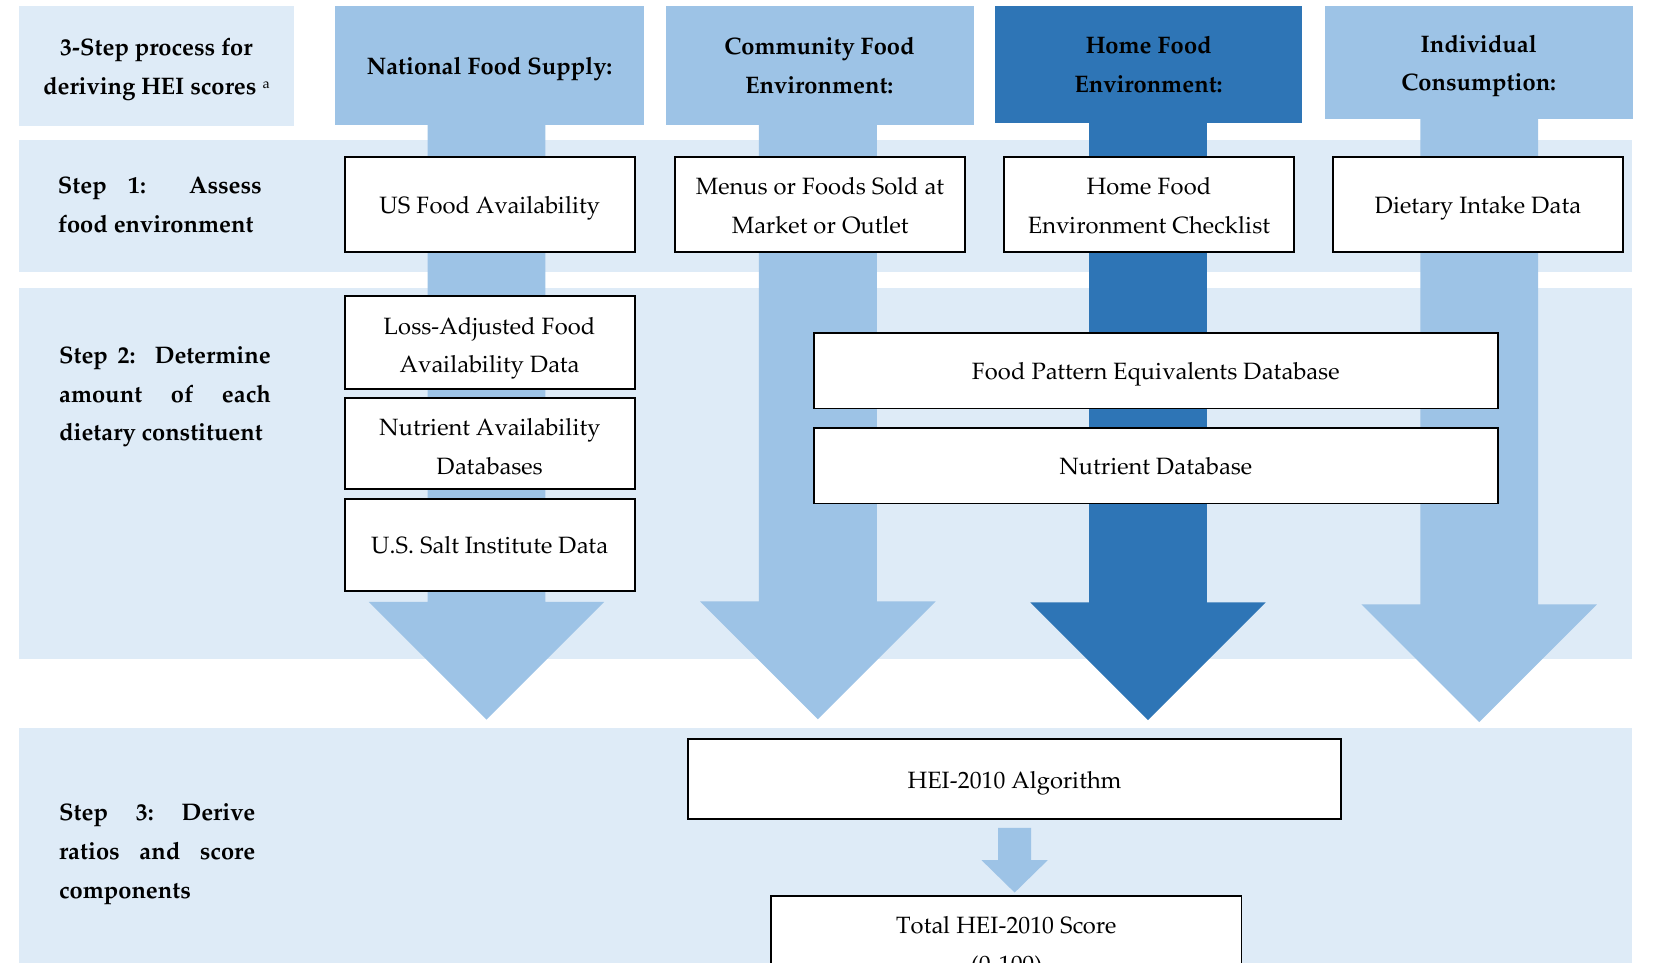
Figure 1. Three step process for deriving Healthy Eating Index (HEI) scores across different levels of the food system.